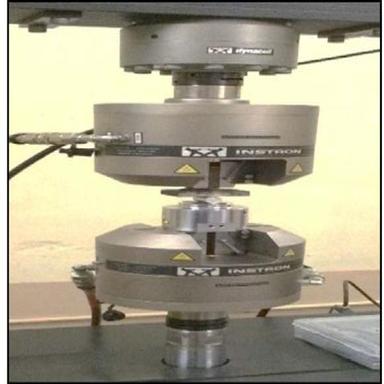
Compression on 9% sample.